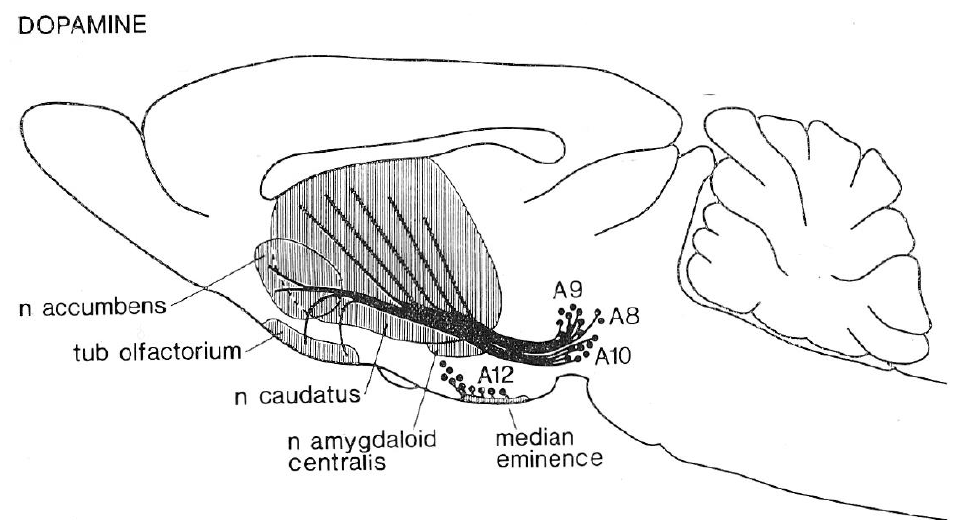
Figure 1. Ascending projections of midbrain dopamine neurons (from [59]).